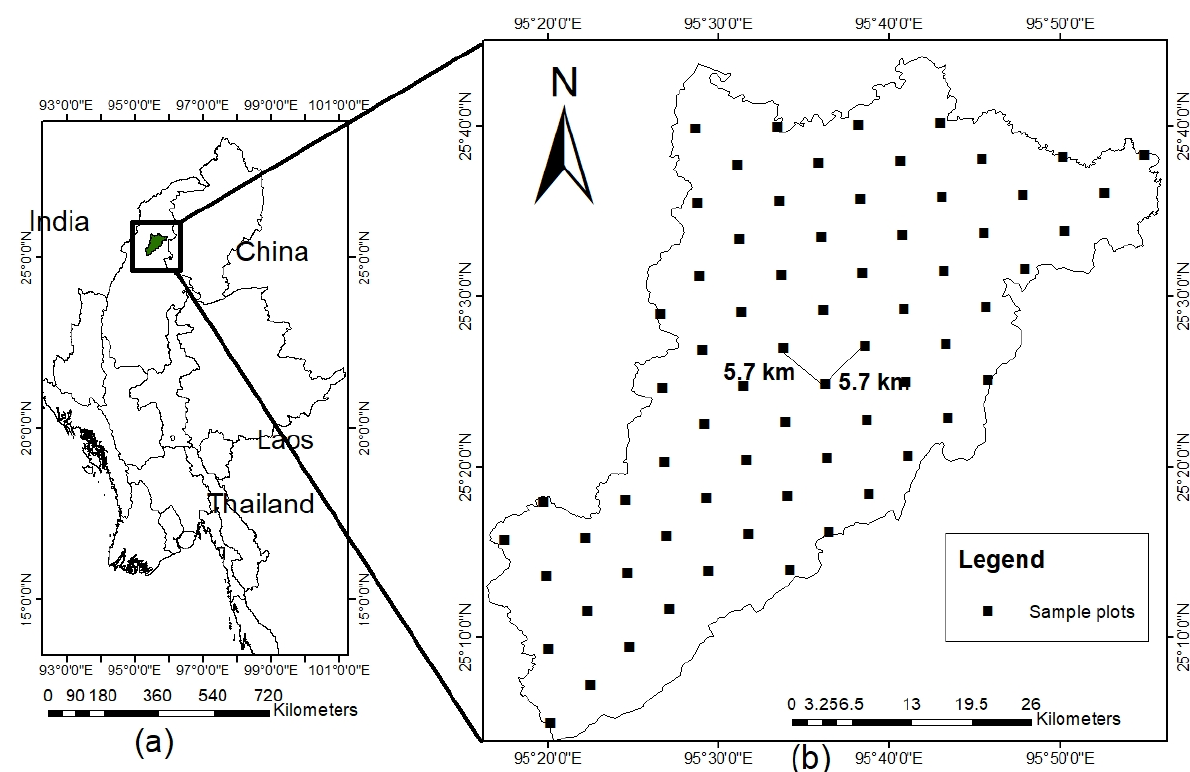
Figure 4. ( a ) Location of study site (Htamanthi Wildlife Sanctuary) and ( b ) distribution of sample plots.